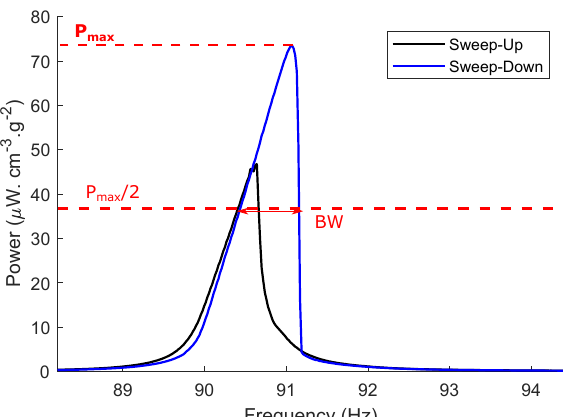
Figure 5. Experimental validation of the optimal configuration of the 2-DOFs model in terms of the average power and the corresponding frequency bandwidth BW.